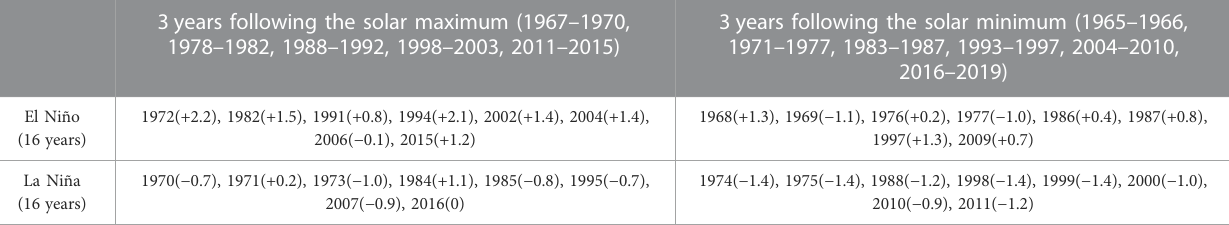
TABLE 4 Standardized TC genesis frequency in the SEWNP during ENSO in the 3 years following the solar maximum and solar minimum from 1965 to 2019. 3 years following the solar maximum (1967 –